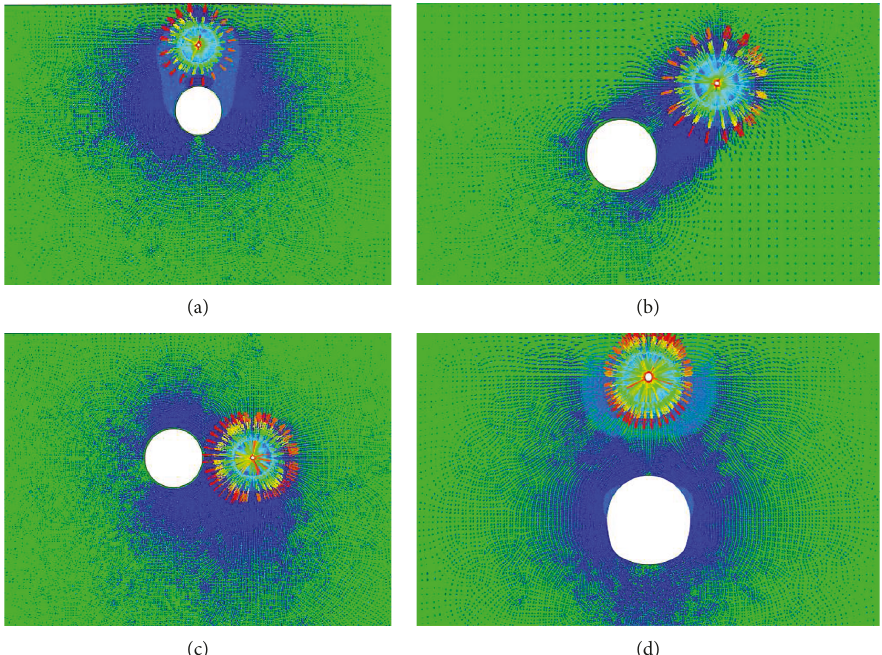
Figure 24: The path of the water fl ow of four conditions. (a) Condition 1; (b) condition 2; (c) condition 3; and (d) condition 6.